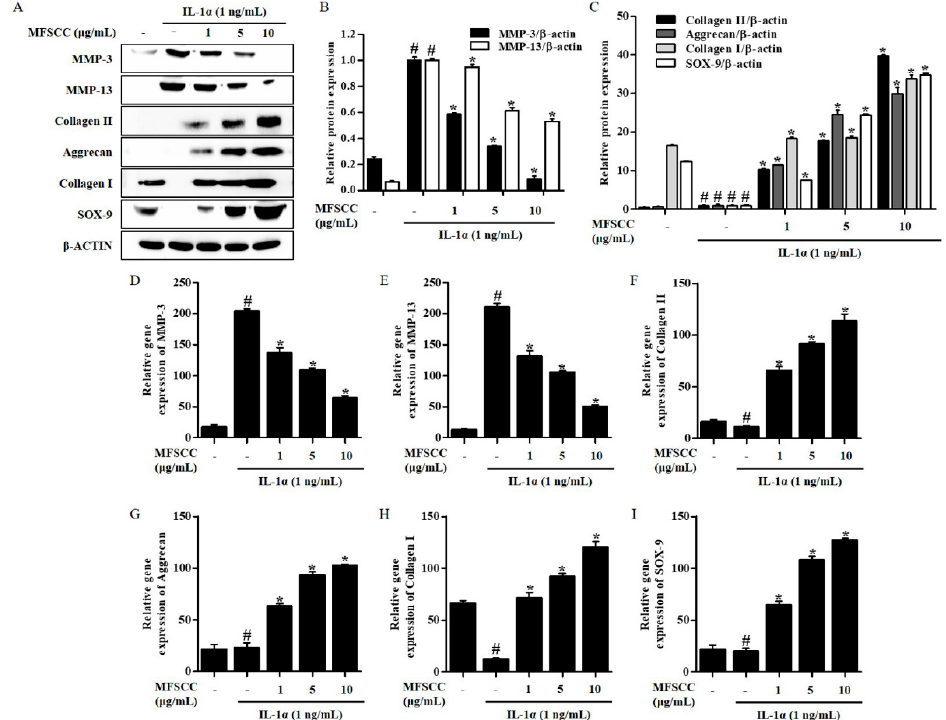
Figure 2. MFSCC suppressed catabolic enzymes production in IL-1 α -stimulated primary chondrocytes. The rat primary chondrocytes were treated with varying concentrations of MFSCC (0, 1, 5, and 10 µ g / mL) for 24 h followed by IL-1 α (10 ng / mL) stimulation for 1 h. The expression of MMP-3, MMP-13, collagen II, aggrecan, collagen I, and SOX-9 was detected by western blot ( A – C ) and qRT-PCR ( D – I ). The data are expressed as mean ± SEM (# p < 0.05 compared with the control group; * p < 0.05 compared with the IL-1 α group).